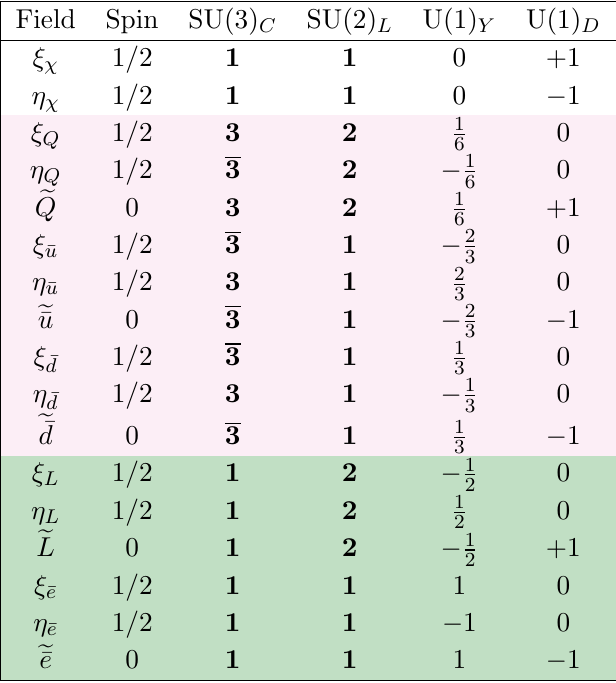
is for stability D